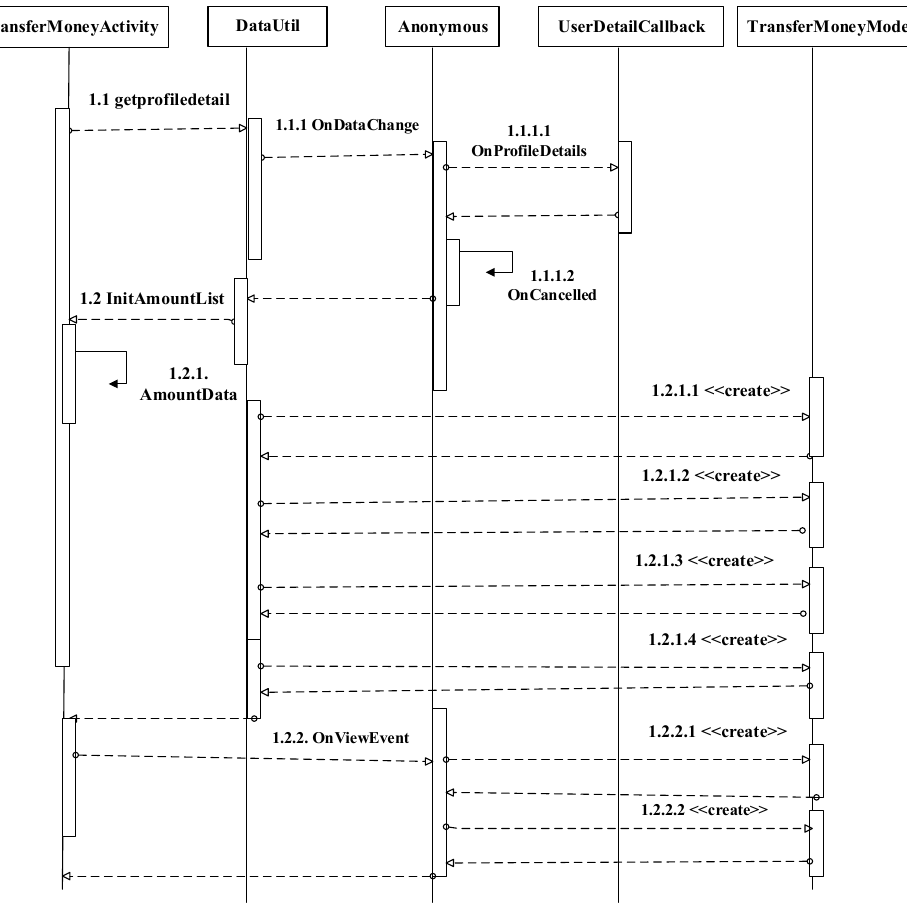
Figure 10. Transfer money activity of proposed method. Step 1.1: The TransferMoneyActivity sends request getProfileDetails to the DataUtil and waits for the response. Step 1.1.1: The DataUtil sends